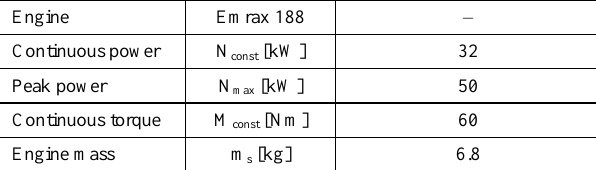
Table 4. Technical data of the Emrax 188 engine [16]